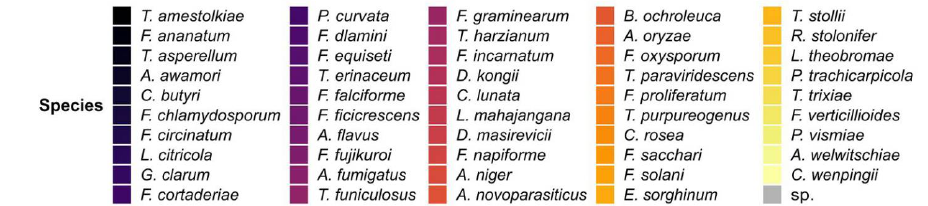
Figure 2. Relative abundances of fungal isolates sampled fro healthy and infected pineapple fruitlets at genus and species taxonomic levels.